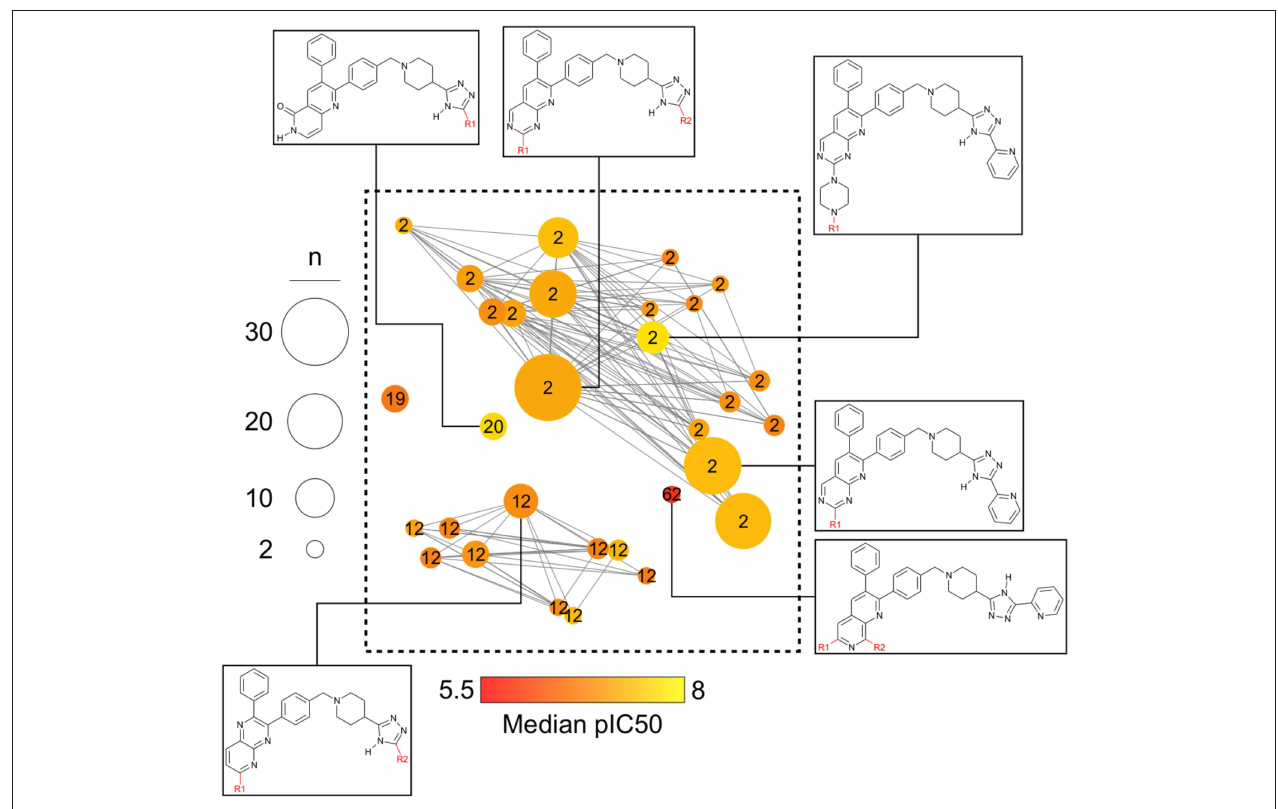
FIGURE 6 | “Zoom-in” into the constellation plot for AKT1 inhibitors selected from Figure 5 . The core in analog series 62 is not as active as the nearby cores in analog series 2 and 12. Few structural differences can be noted for the compounds in this